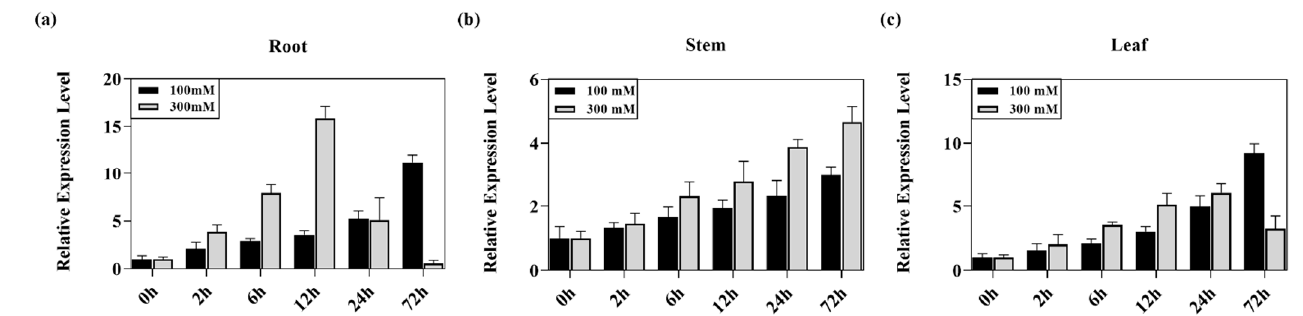
Figure 3. Expression pattern of PeMKK2a under salt stress. “Nanlin895” were exposed to salt stress at 100 mM and 300 mM for 0 h, 2 h, 6 h, 12 h, 24 h, and 72 h. Samples were taken for quantitative analysis. ( a ) Relative expression level in root. ( b ) Relative expression level in stem. ( c ) Relative expression level in leaf.